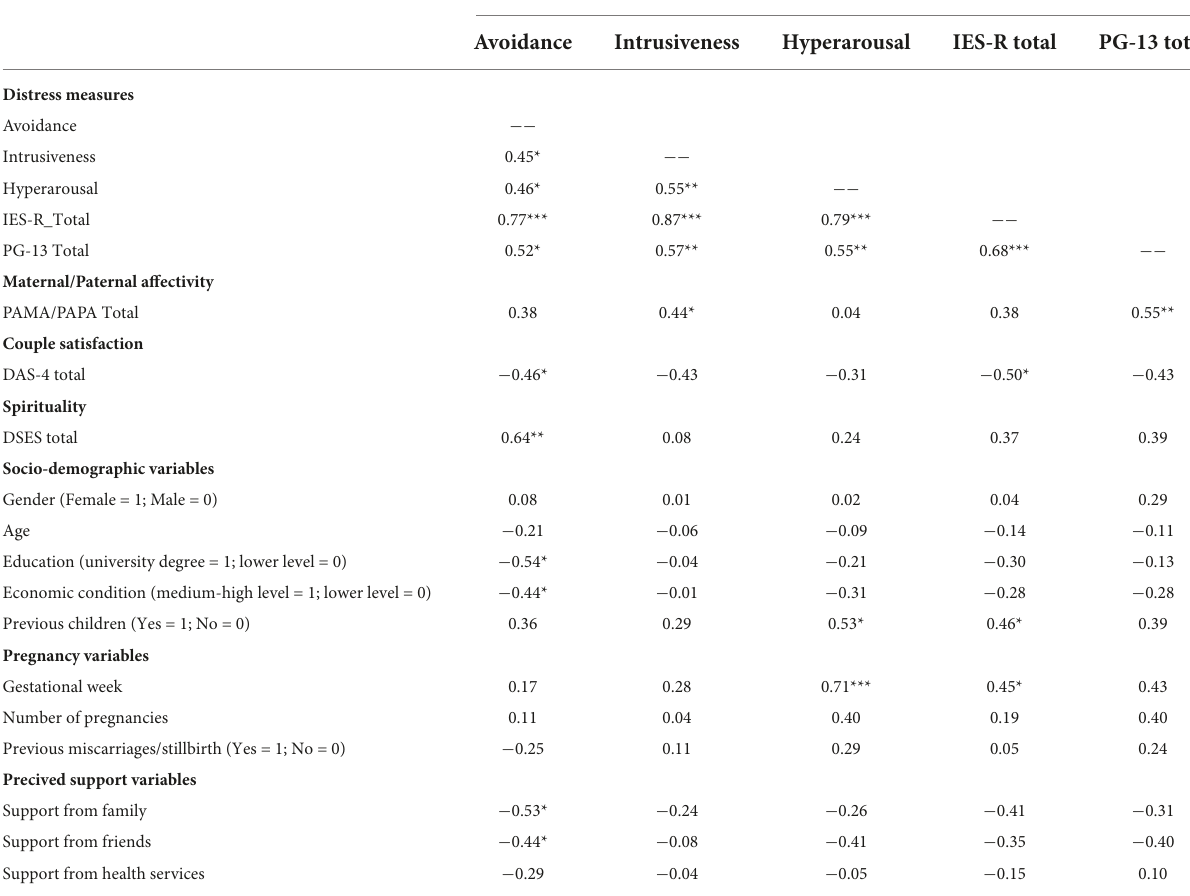
TABLE 1 Correlations of distress measures with maternal/paternal affectivity, couple satisfaction, spirituality and with socio-demographic, pregnancy, and perceived support variables ( N = 21).